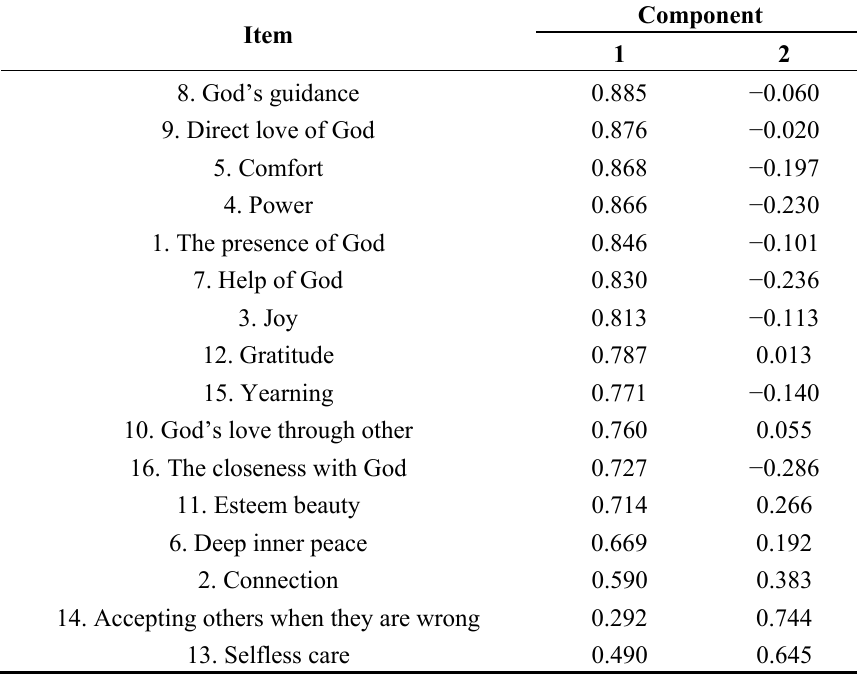
Table 4. Overview of the factor structure (components) before rotation. Item